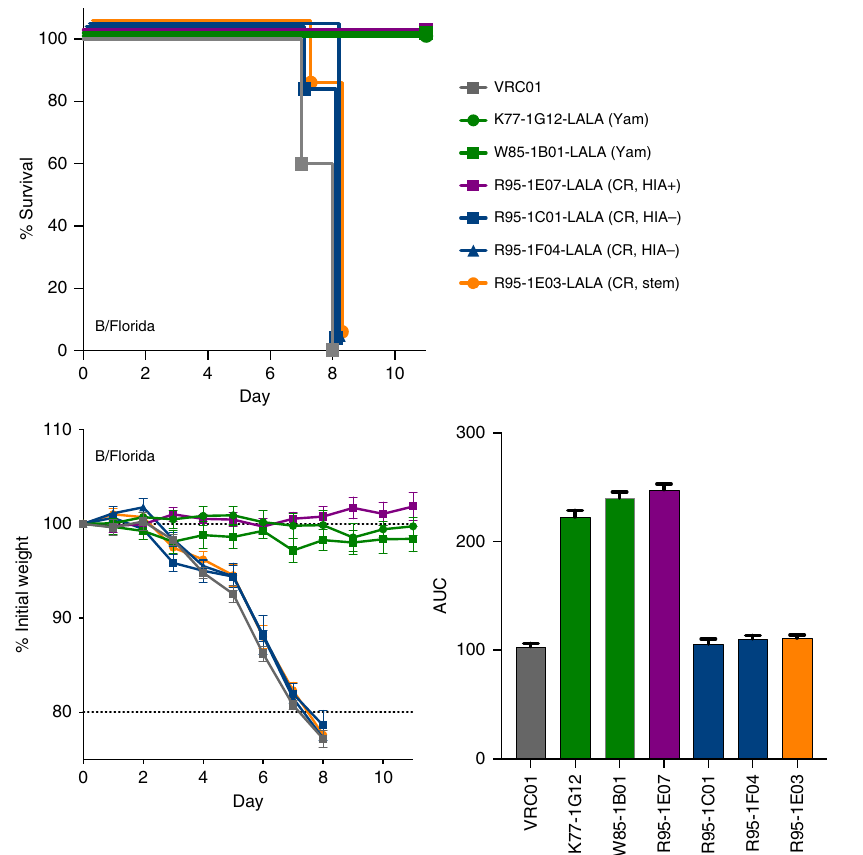
Fig. 5 Protection by IBV stem or HIA − mAbs requires engagement with cellular Fc receptors mice ( N = 5 per group) were infused with 5 mg/kg of anti-IBV mAbs expressed on a human IgG1 Fc with incorporated L234A/L235A (LALA) mutations. Twenty-four hours later, mice were challenged with 50 TCID 50 B/Florida/4/2006. Animal weights were monitored over an 11 day period, with animals killed if weight loss exceeded 20% of starting weight. Survival curves and weight loss are plotted as mean ± SEM, and the relative protection of each mAb assessed using area under the curve (AUC) analysis and plotted as mean ± SEM. Controls (grey), B/Yamagata-speci fi c (red), B/Victoria-speci fi c (green), cross-reactive HIA-positive (magenta), cross-reactive HIA-negative (blue) and cross-reactive stem mAbs (yellow) are indicated. Yam: Yamagata-speci fi c lineage, CR: cross-reactive, HIA + : showed HIA activity in vitro, HIA − : no HIA activity in vitro, stem: bound epitopes within the HA